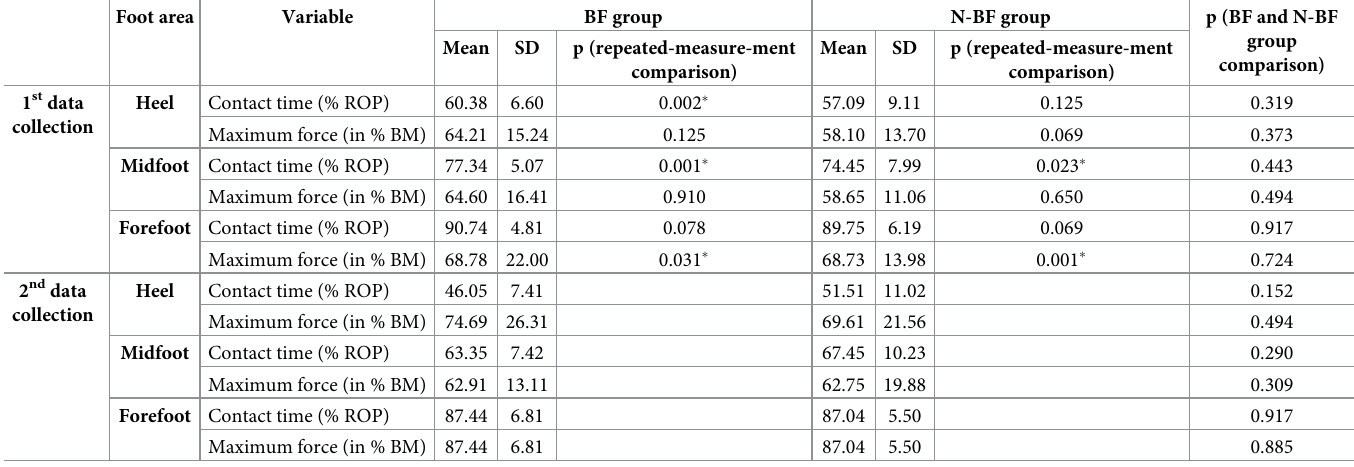
Table 5. Results of analysed gait parameters in the heel, midfoot and